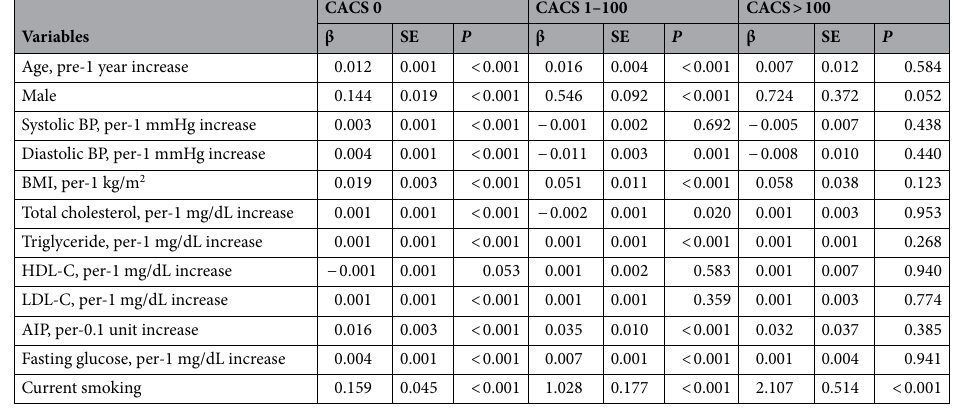
Table 2. Clinical variables and annualized Δ√transformed CACS according to baseline CACS. AIP atherogenic index of plasma , BMI body mass index, BP blood pressure, CACS coronary artery calcium score,